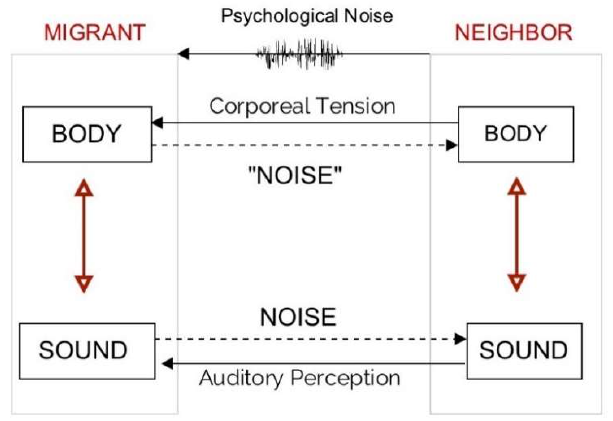
Figure 6. Conceptual framework of noise by the actual sound and ‘noise’ by the corporeal tension.